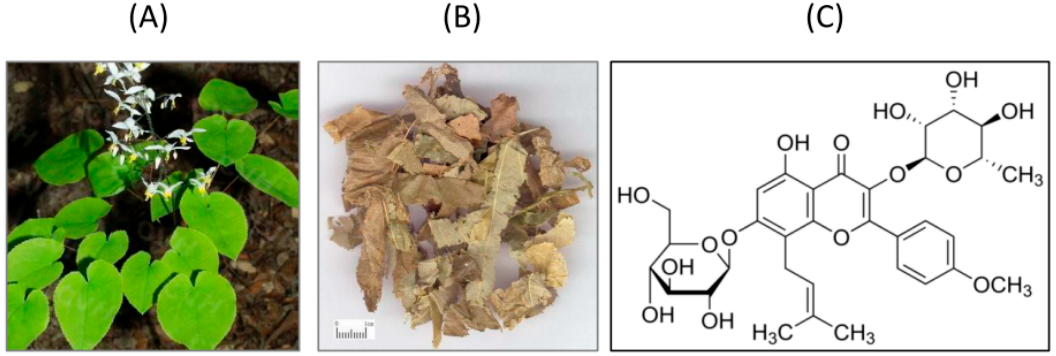
Figure 1. Photos of Epimedium brevicornum Maxim ( A ) The plant ( B ) The dry leaves ( C ) The chemical structure of icariin.